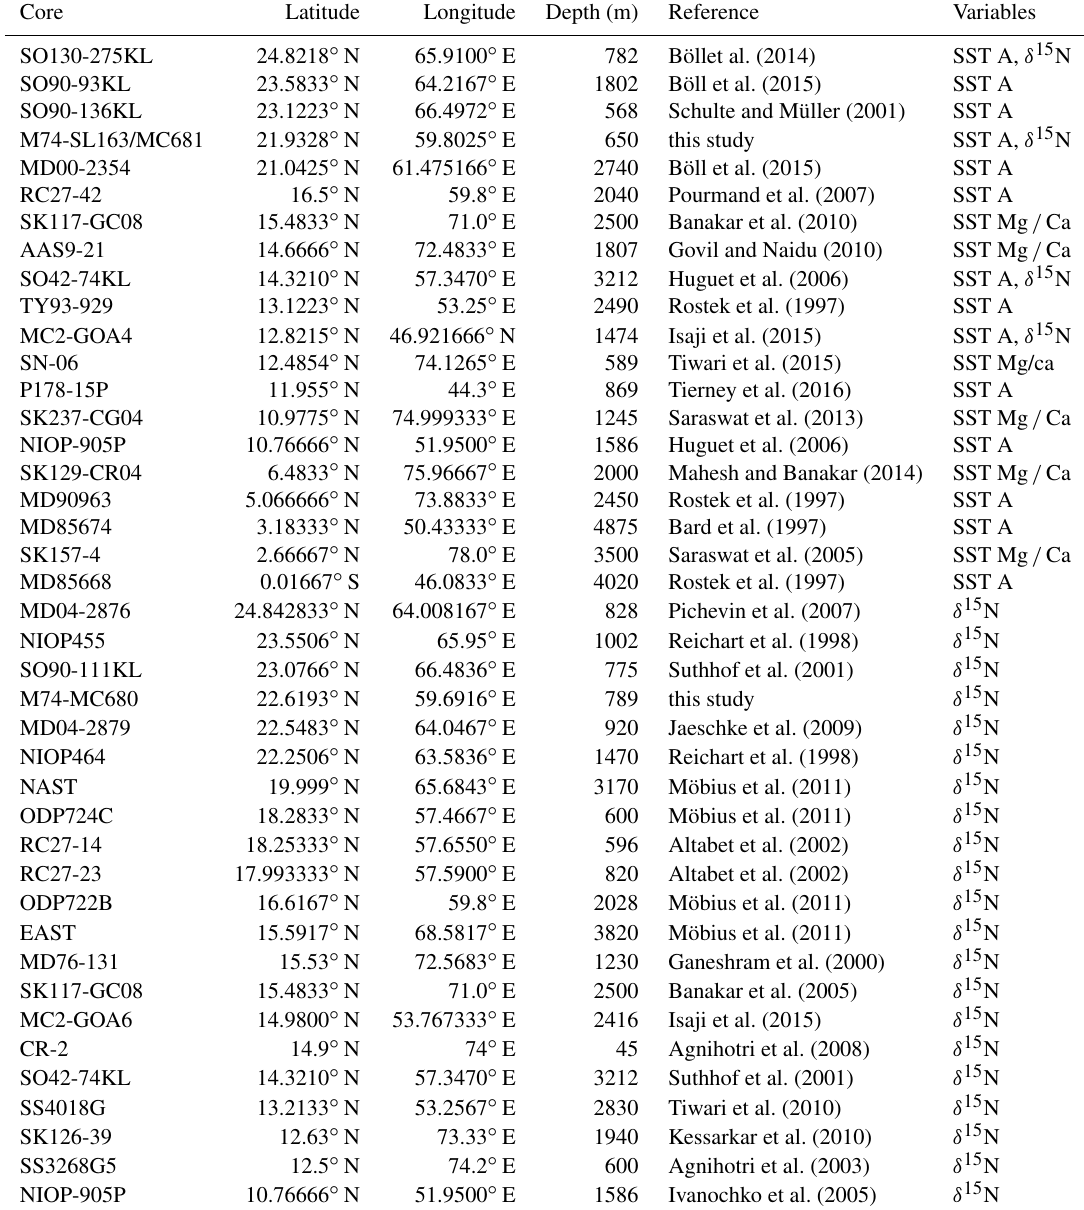
Table 1. Station number, locations, water depth (m), data sources (references), and variables used: SST A (alkenone sea surface temperatures), δ 15 N ratios of total N, and SST Mg / Ca (Mg / Ca sea surface